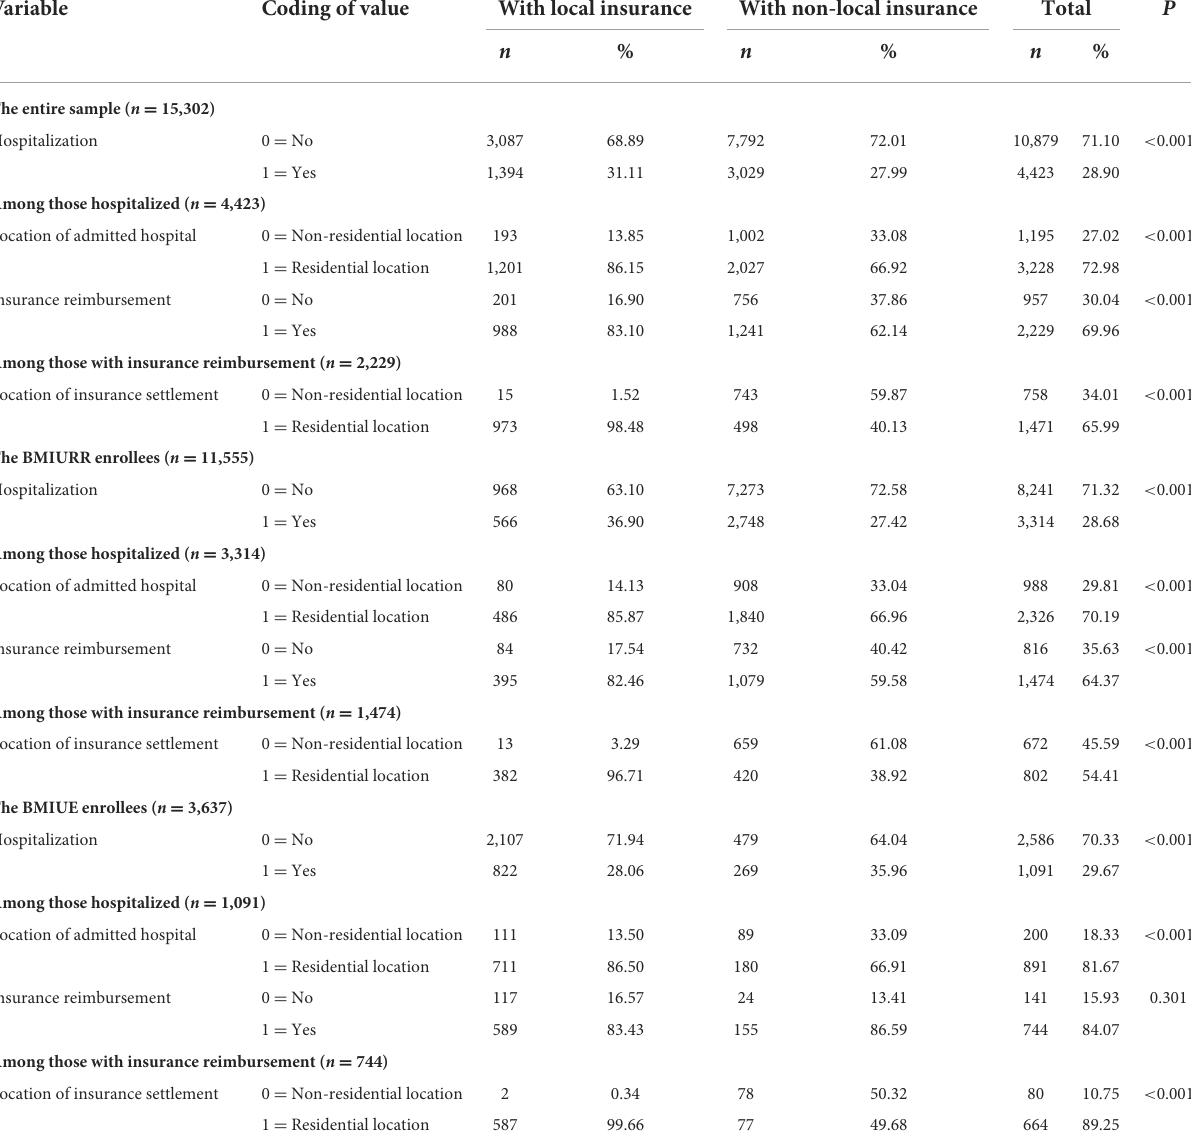
TABLE 2 Use of health insurance for hospital care in study participants.